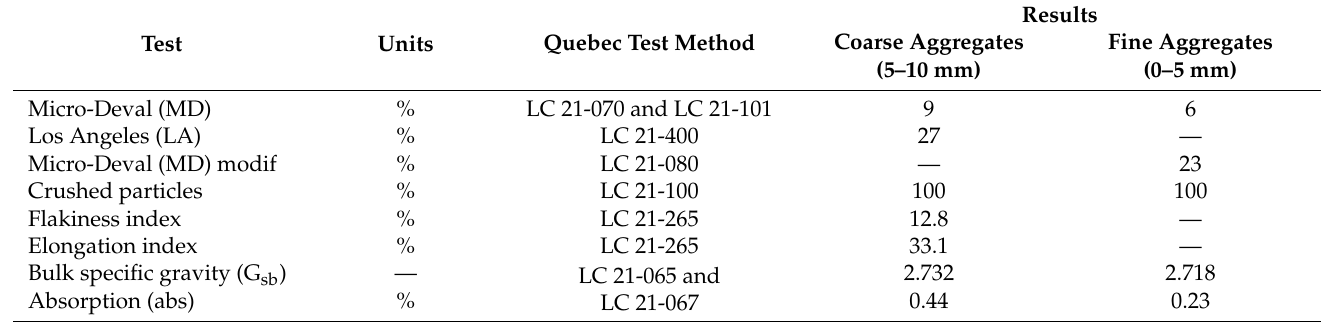
Table 1. Virgin aggregate properties.